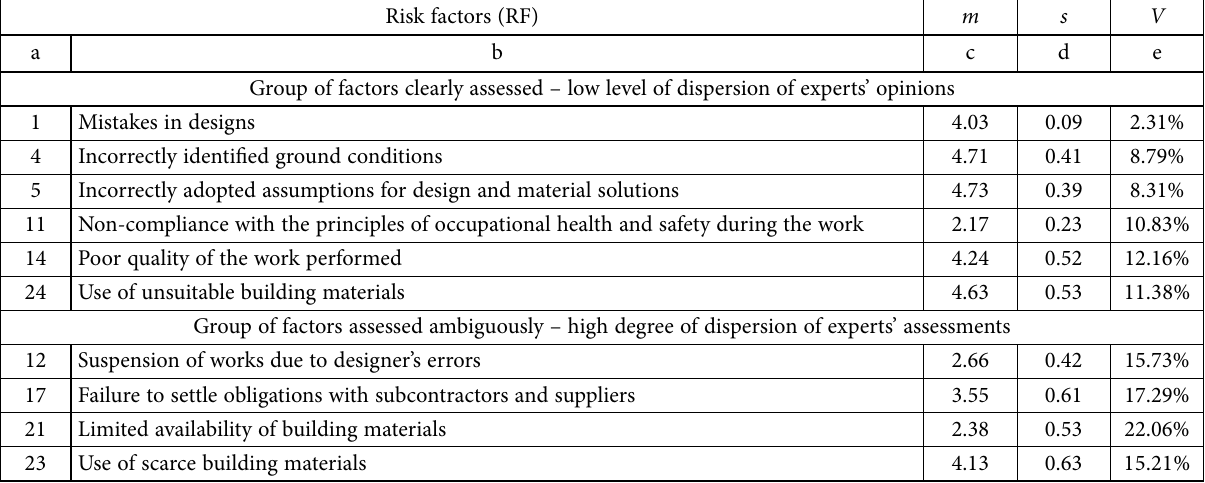
Table 10. Sensitivity analysis results for risk factors for which fuzzy measures of risk impact on the size of the life cycle costs of buildings were defined (own study) Risk factors